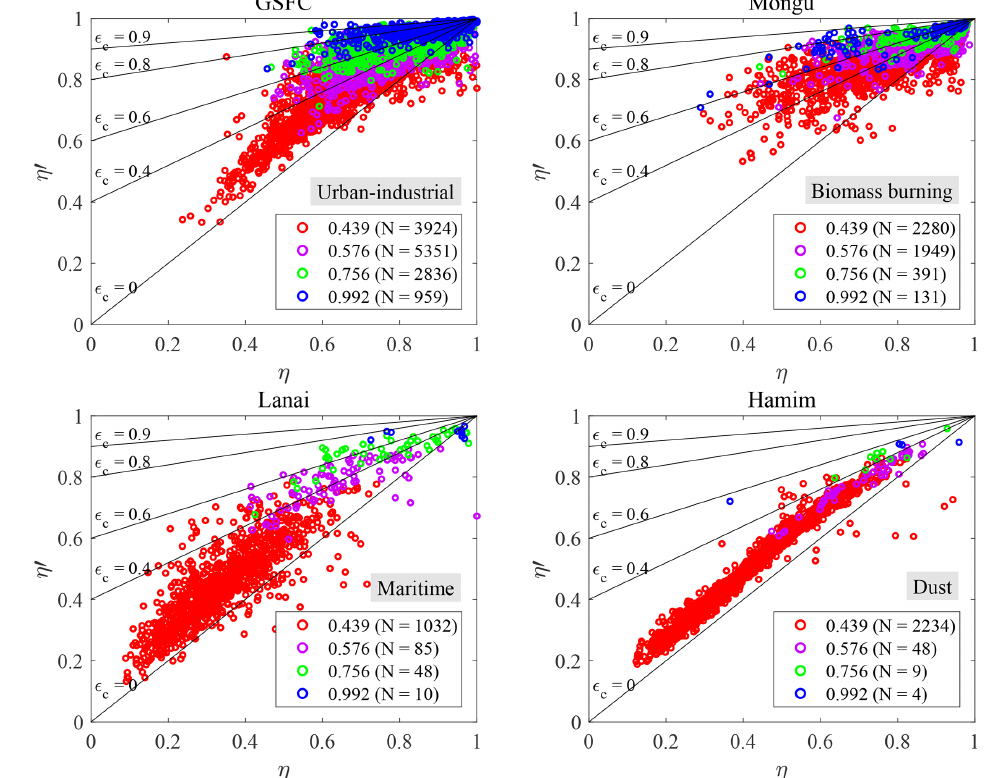
Figure 6. η (cid:48) vs. η (AERinv-derived SMF vs. SDA-derived FMF) scattergrams for the sites of GSFC, Mongu, Lanai and Hamim (aerosol types of urban-industrial, biomass burning, marine and dust, respectively, as per Table 1). The four colors represent the four different AERinv inflection points ( r 0 values with units of µm). The remaining scattergrams for the other sites are shown in Fig. S1. The solid black lines are those of Eq. (7a), with ε f set to zero (for the sake of the simplicity of the presentation coupled with the fact that ε f plays a relatively minor role).